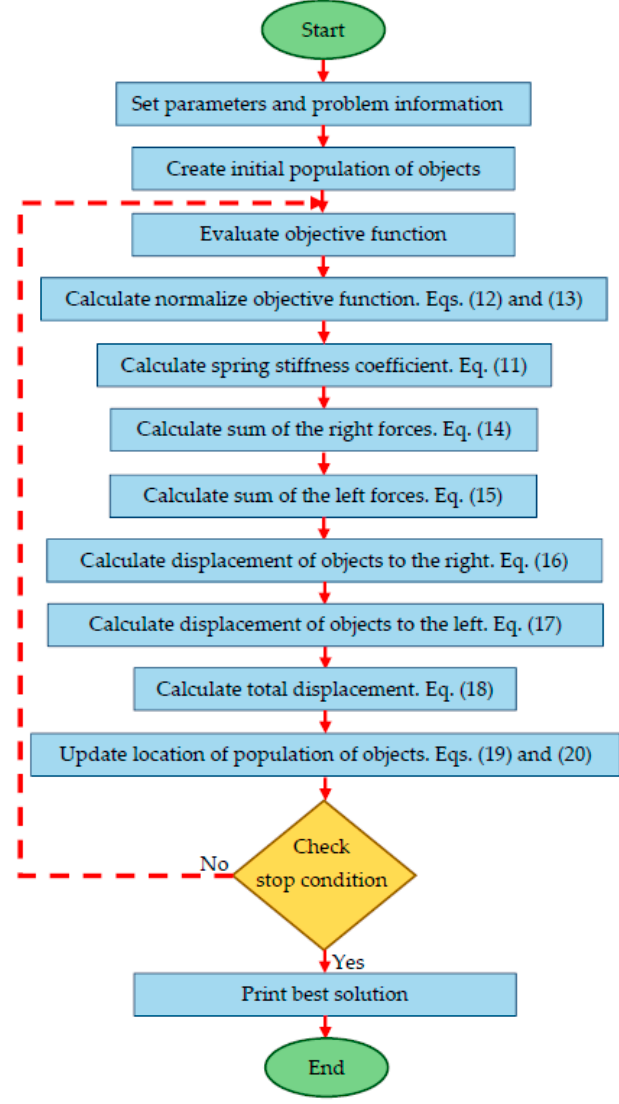
Figure 2. Spring Search Algorithm Flowchart.